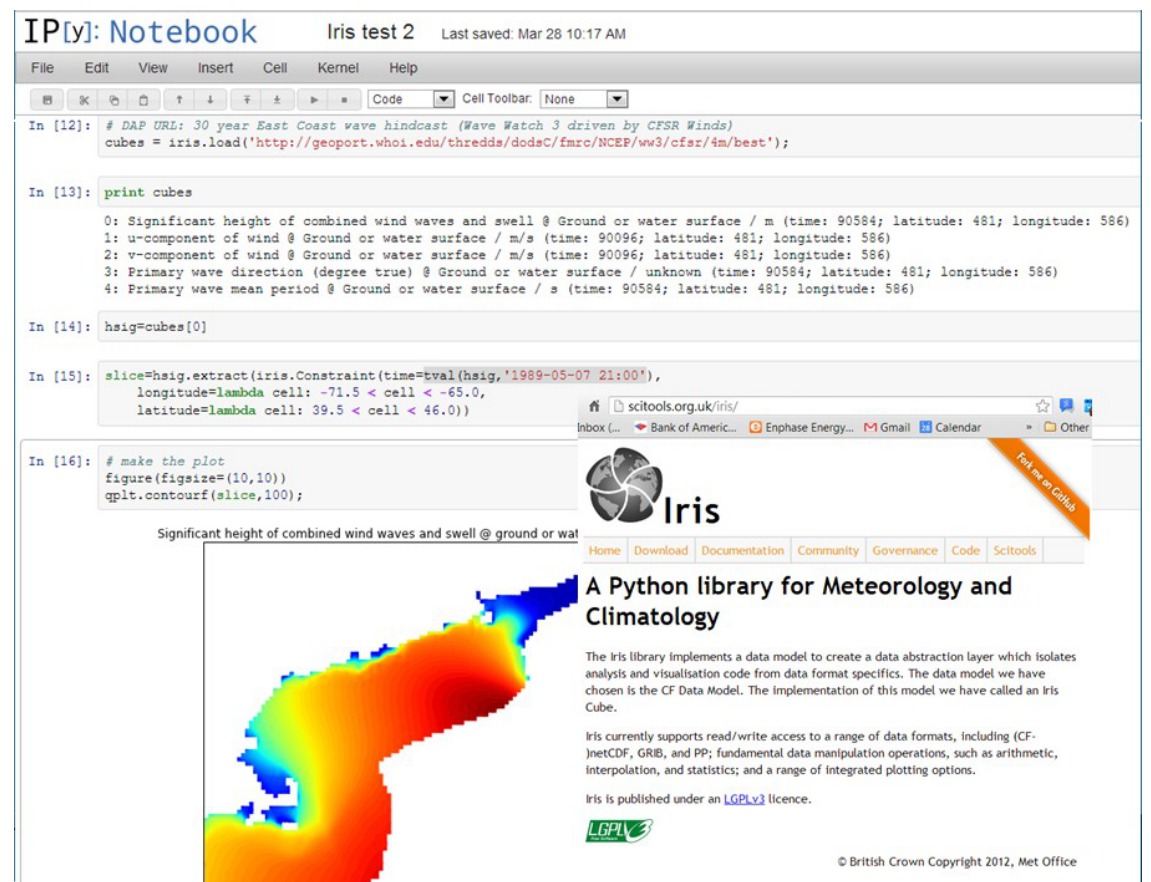
Figure 7. Access and display of CF-compliant WaveWatch III data using the Python Iris package from the British Met Office. This demonstration was done using the IPython Notebook, which allows code, output and rich text to be combined in a web document that can be easily shared with